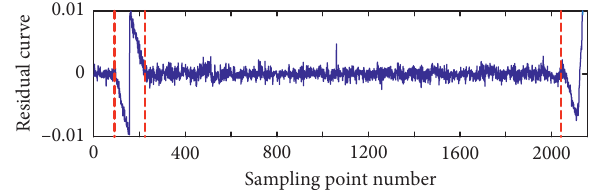
Figure 5: RMS value of the full bearing life